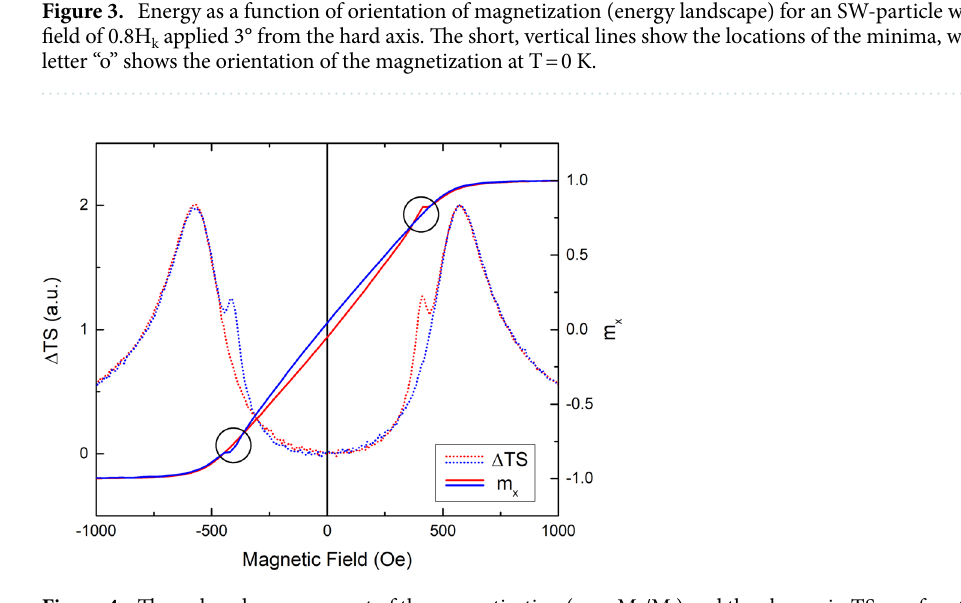
Figure 4. The reduced x-component of the magnetization (m x = M x /M s ) and the change in TS as a function of applied field 2° from the hard axis. Ascending and descending curves are shown in red and blue, respectively. Black circles highlight the hysteresis branch crossings. Note that the crossing of hysteresis branches occurs at the same applied field as the irreversible TS